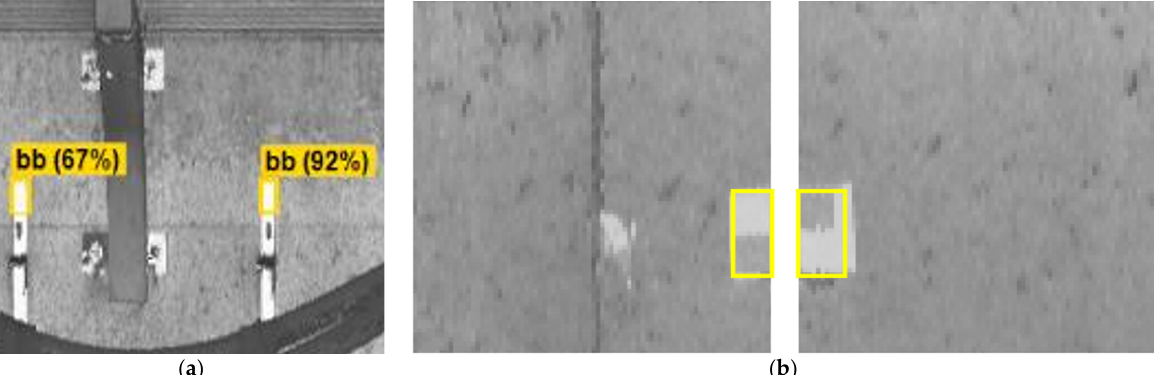
Figure 10. ( a ) False positives caused by metal support; ( b ) false positives caused by clipping of pic- ture.